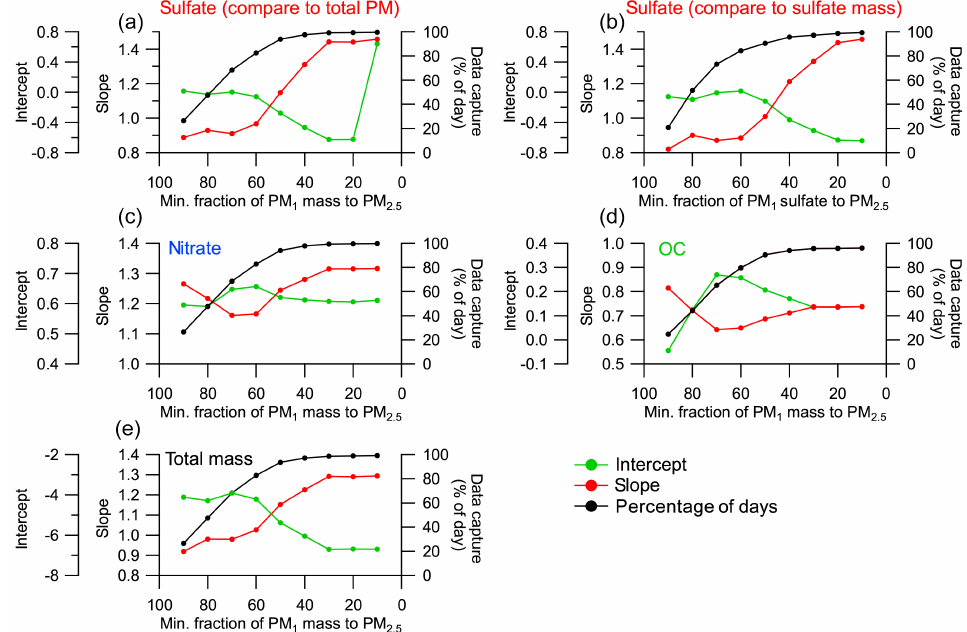
Figure 3. Sensitivity analysis of the correlation between ACSM and PM 1 sulfate, nitrate, OC, and total mass concentration depending on the PM 1 :PM 2 . 5 ratio of the total mass concentration in the range 90%–10%. The influence of sulfate distribution on PM 1 and PM 2 . 5 was also